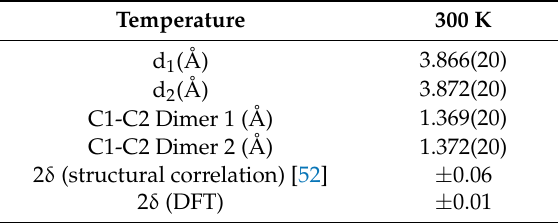
Table 1. Relevant interatomic distances for the structure at 300 K. The charge disproportionation 2 δ defined in the text and calculated from the structural correlation as well as that from DFT calculations are also